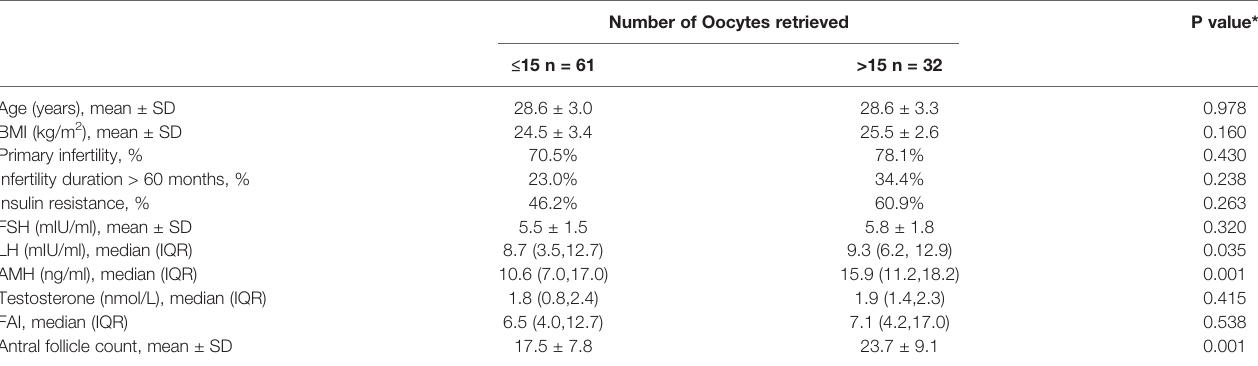
TABLE 2 | Factors in fl uencing the number of oocytes retrieved during IVM-surgery.